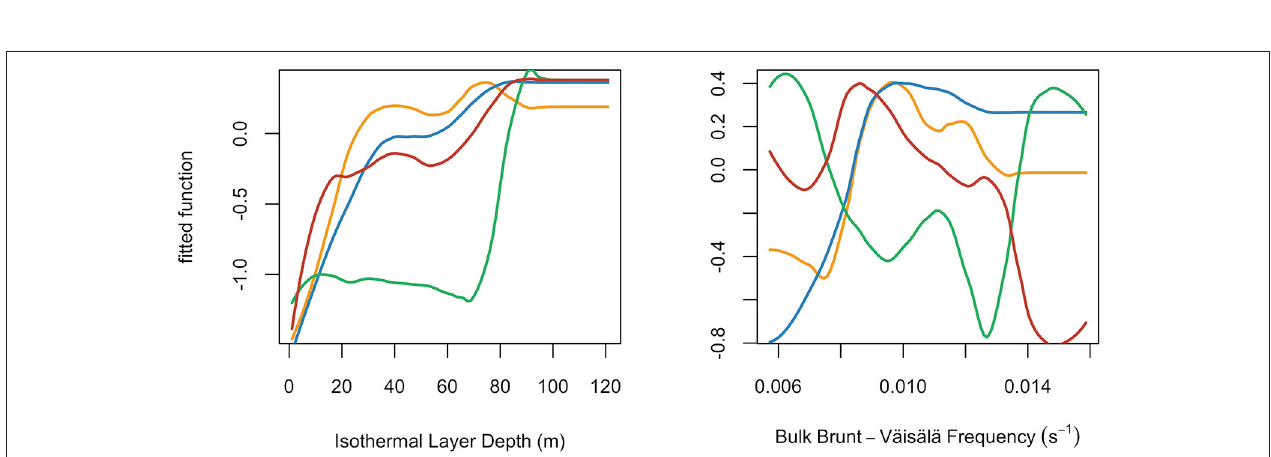
FIGURE 2 | Spider plots of the relative influence (%) of each environmental variable within species distribution models: swordfish (yellow); blue sharks (blue); common thresher sharks (green); shortfin mako sharks (red). Variable acronyms are described in Table 2 .